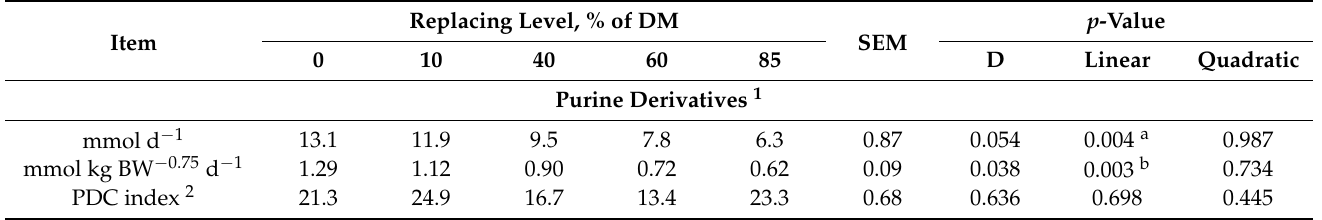
Table 5. Urinary purine derivatives (PD) and PD/creatinine index using spot samples collected at 4 h after morning feeding in lambs fed diets (D) containing peach palm replacing